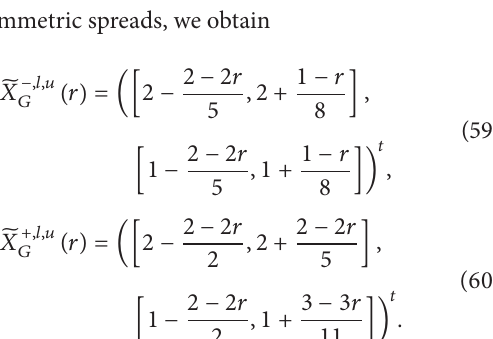
̃𝑏 (−) and the value of the first row for ̃𝑥 −,𝑙,𝑢 2